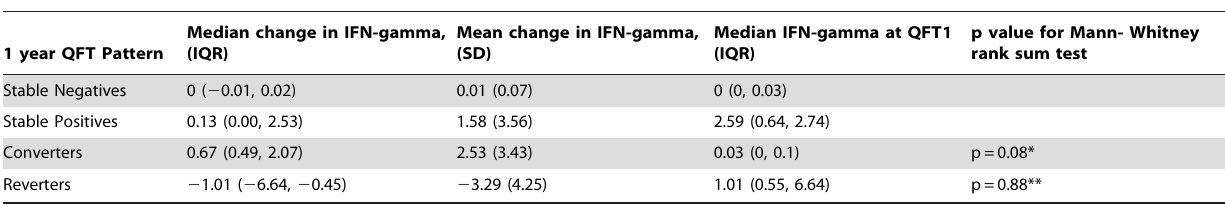
Table 7. Median and IQR values for QFT1 and difference in Interferon-gamma levels (IFN-g at QFT2– IFNg at QFT1 (IU/ml) and stratified by 1 year QFT